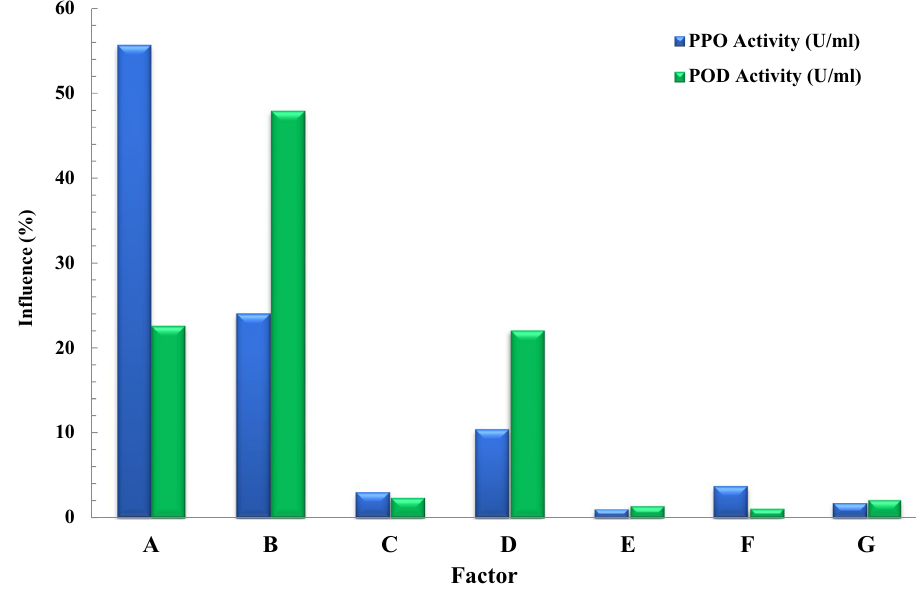
Figure 5. Percentage contribution of each variables on PPO and POD